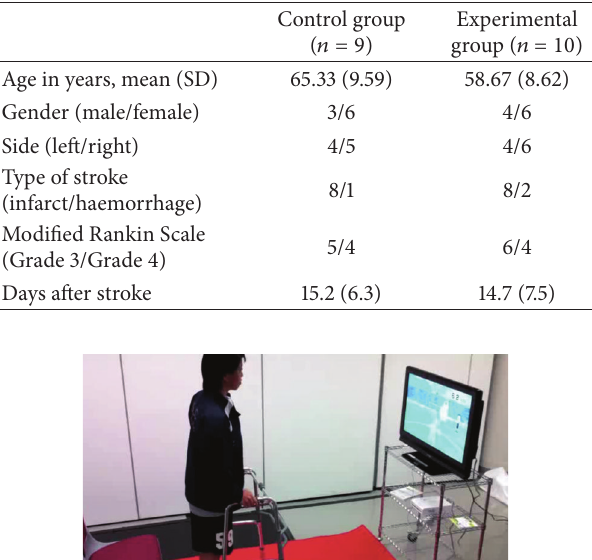
Table 1: Characteristics of subjects in the experiment and control groups.